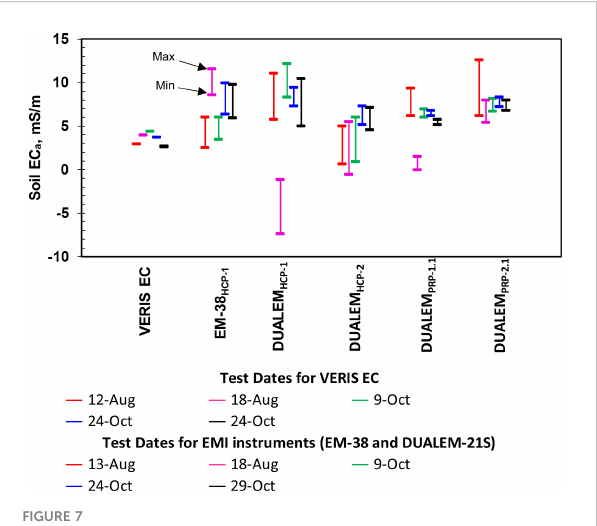
FIGURE 7 The range (minimum and maximum) of soil EC a measurements during temporal